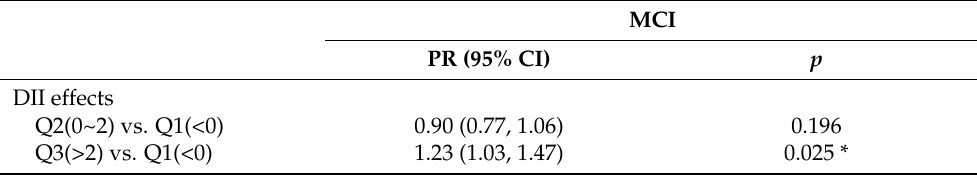
Table 6. The effects of DII, SII and SIRI on the occurrence of MCI by log-binomial